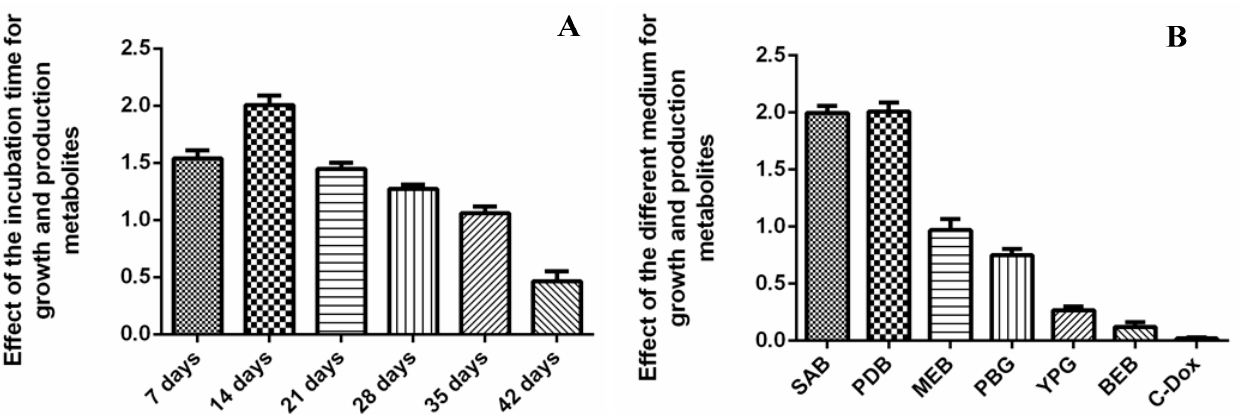
Figure 4. Optimization of incubation time ( A ) and different medium for production secondary metabolites ( B ) by leading endophytic fungus of O. senegalensis NR-03.